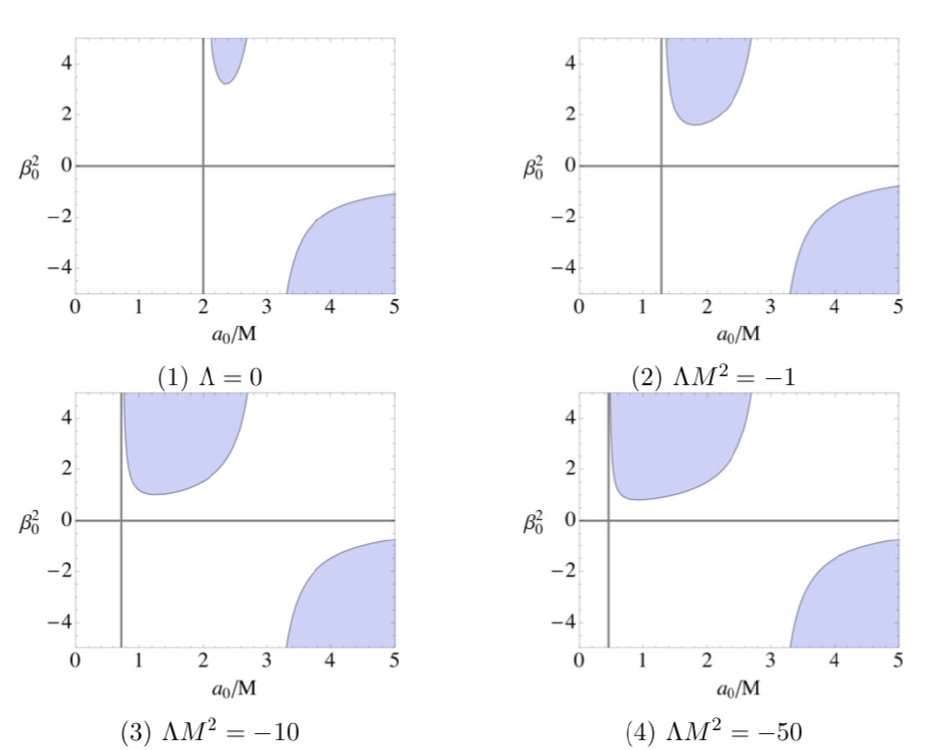
Figure 11. Schwarzschild–anti de Sitter thin-shell wormhole. The shaded regions indicate the